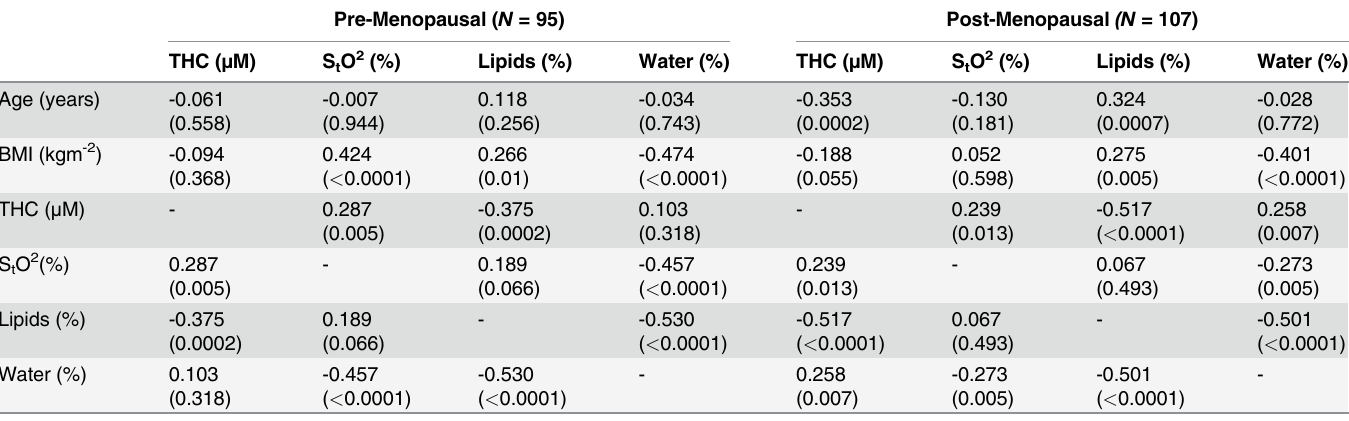
Table 3. Results of Pearson correlation analysis of OS parameters with age, BMI and each other among pre- and post-menopausal women.